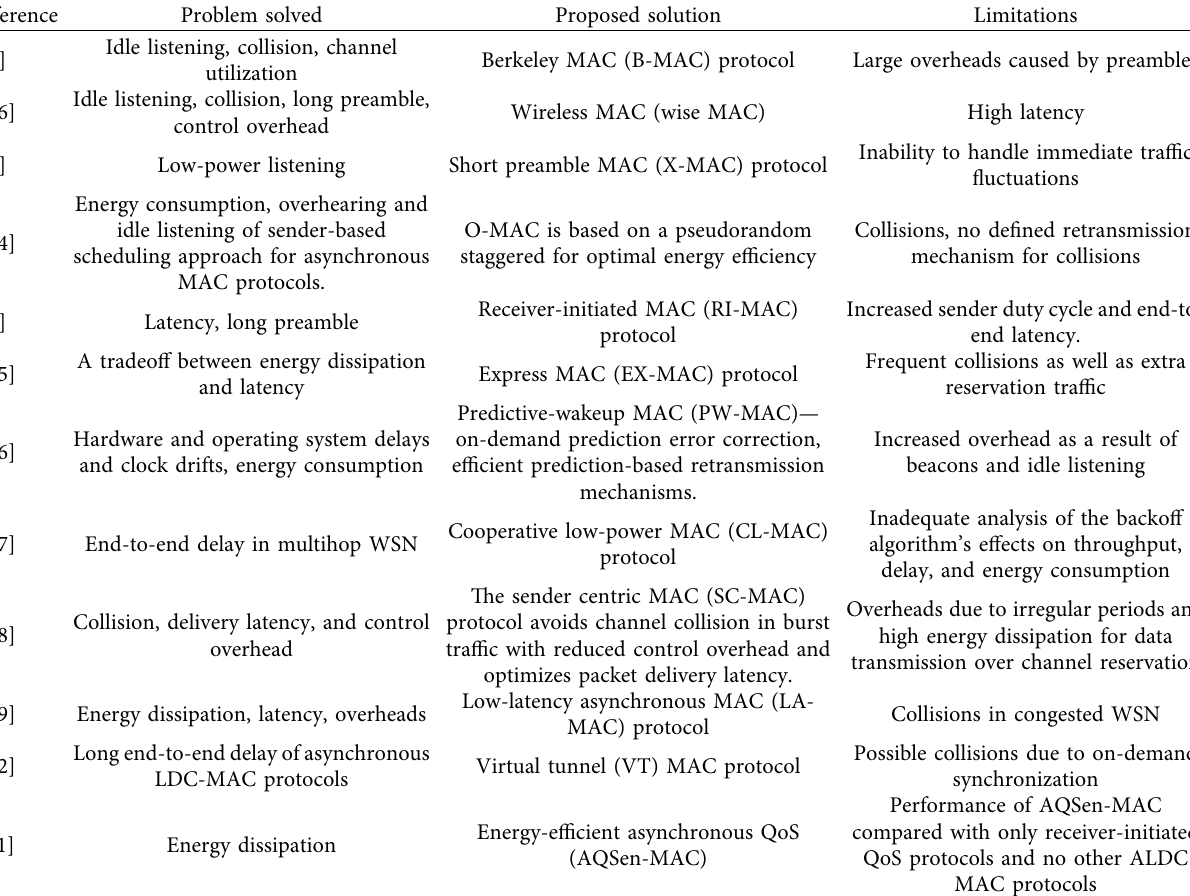
Table 3: Comparative study of ALDC MAC